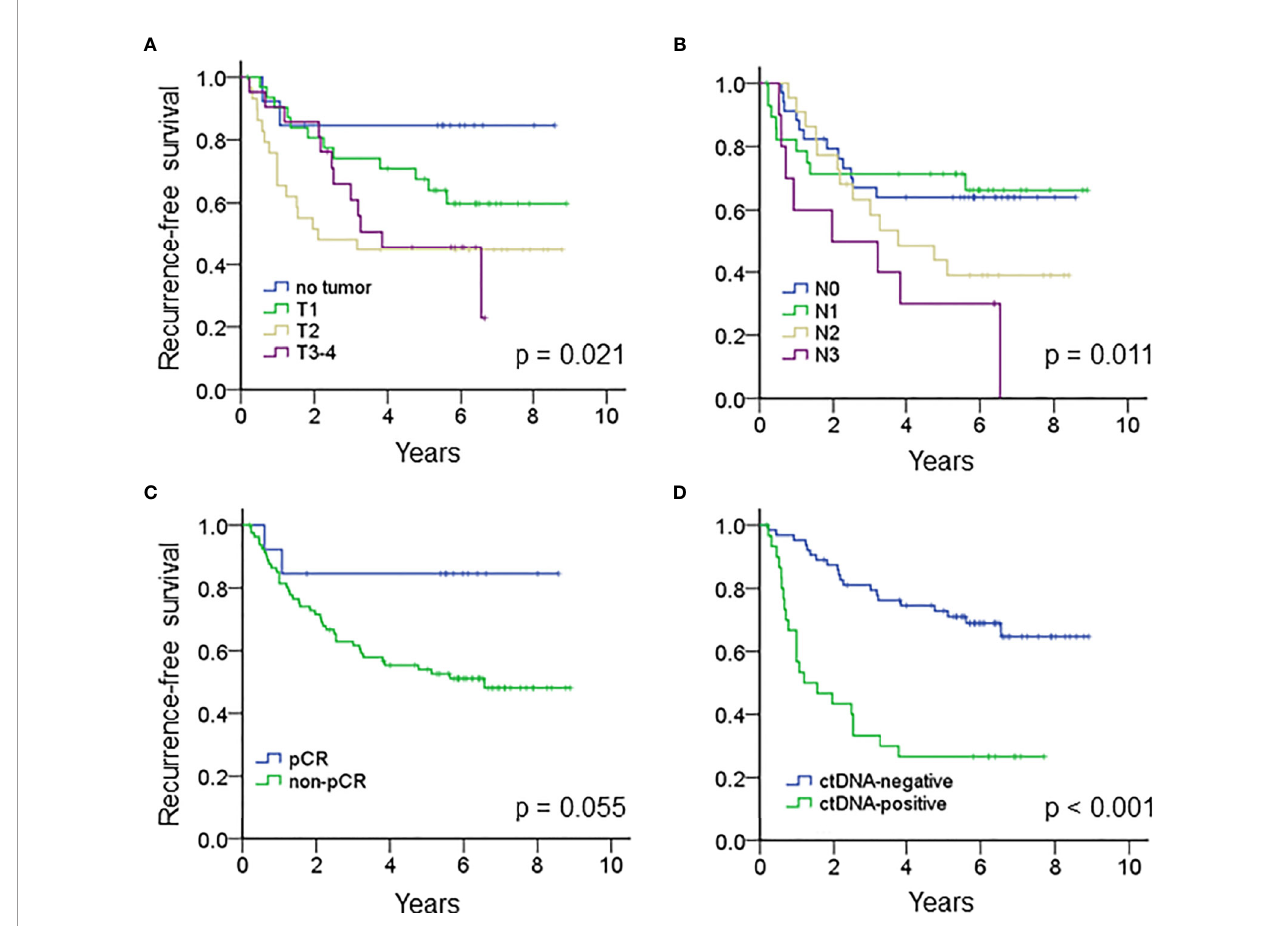
FIGURE 2 | Kaplan-Meier analysis estimated the recurrence-free survival of the entire cohort according to (A) the tumor size after NAT (p = 0.021), (B) N classi fi cation after NAT (p = 0.011), (C) pCR (p = 0.055) and (D) ctDNA after NAT (p <